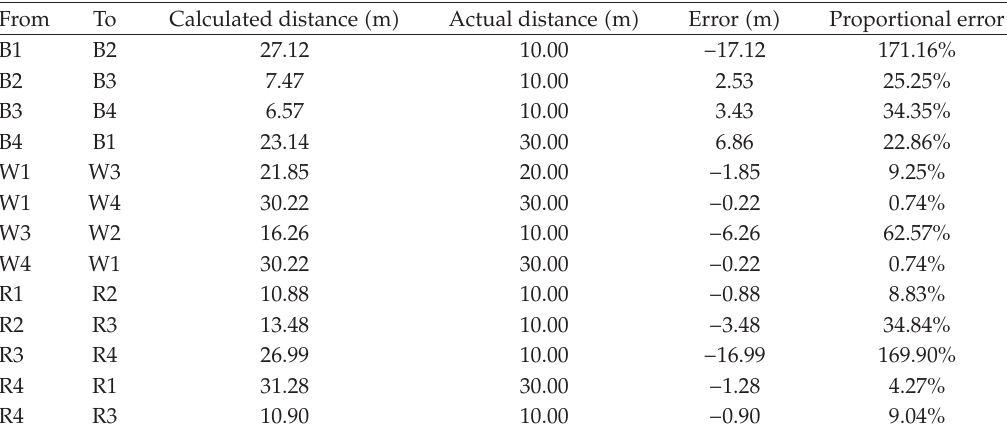
Table 2: Stationary positioning accuracy of